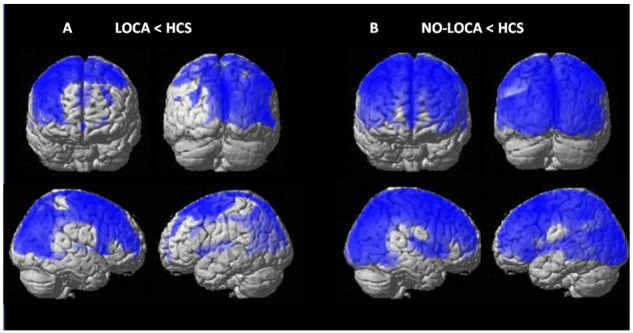

18FDG-PET results. Areas showing significant metabolic impairment (in blue) in A NO-LOCA and B LOCA patients in UWS compared with HCS, thresholded at P < 0.05 FDR-corrected for multiple comparisons (at the whole-brain level).